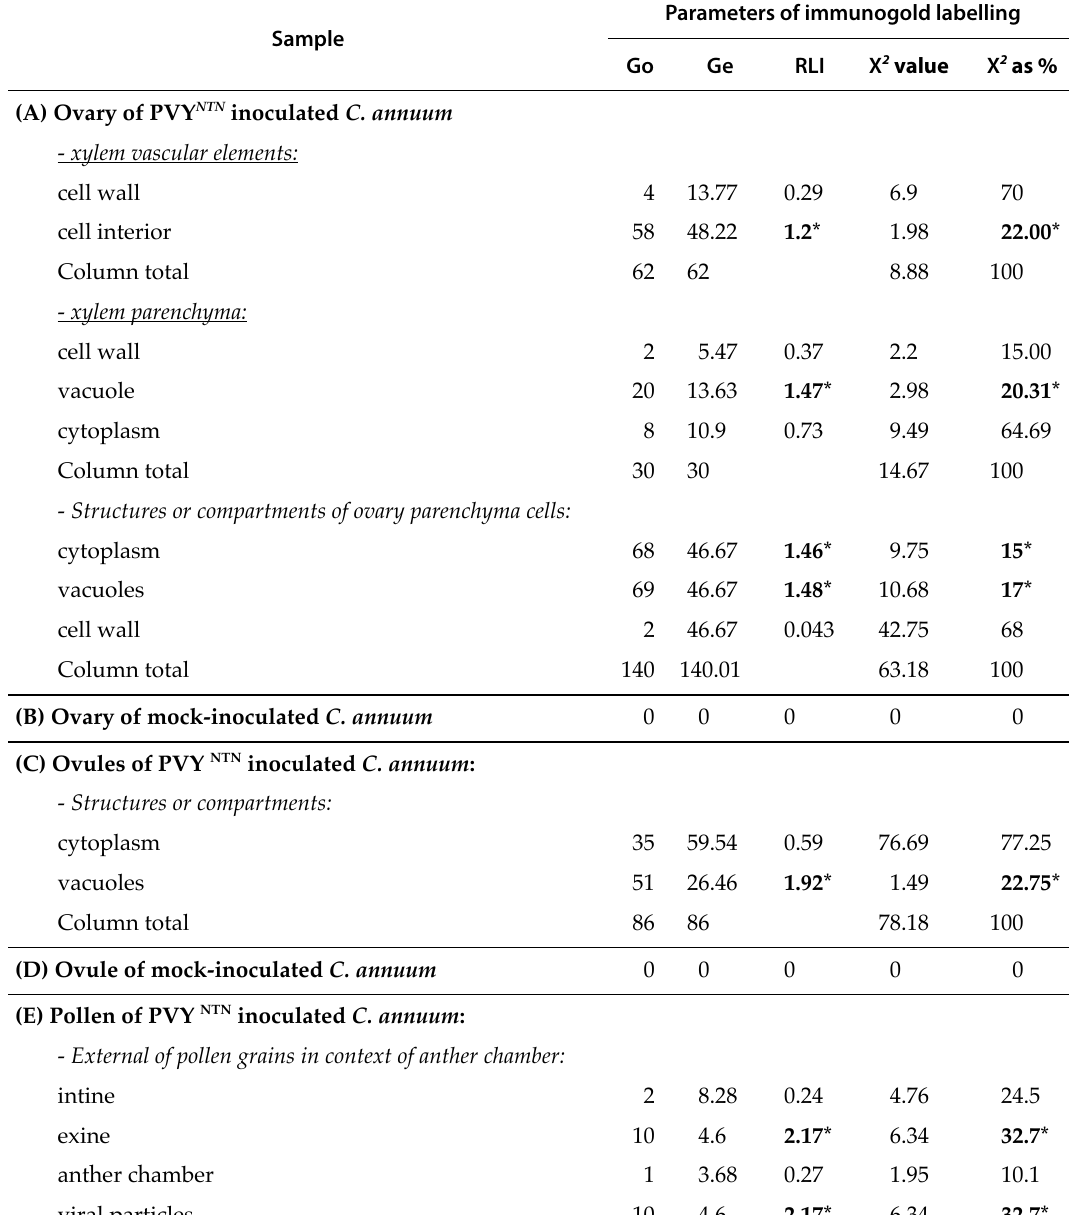
Table 1. Quantification of immunogold labelling by RLI and Χ 2 test. Assessment of immunogold labelling in PVY NTN infect- ed C. annuum : vascular tissue of ovary (A), ovules (C), pollen (E), anther (G) and next generation plants (H). Assessment of immunogold labelling in mock-inoculated C. annuum elements: ovary (B), ovule (D), pollen and anther (F). Significant values (RLI > 1, and % Χ 2 at least 10%) in bold font and marked with